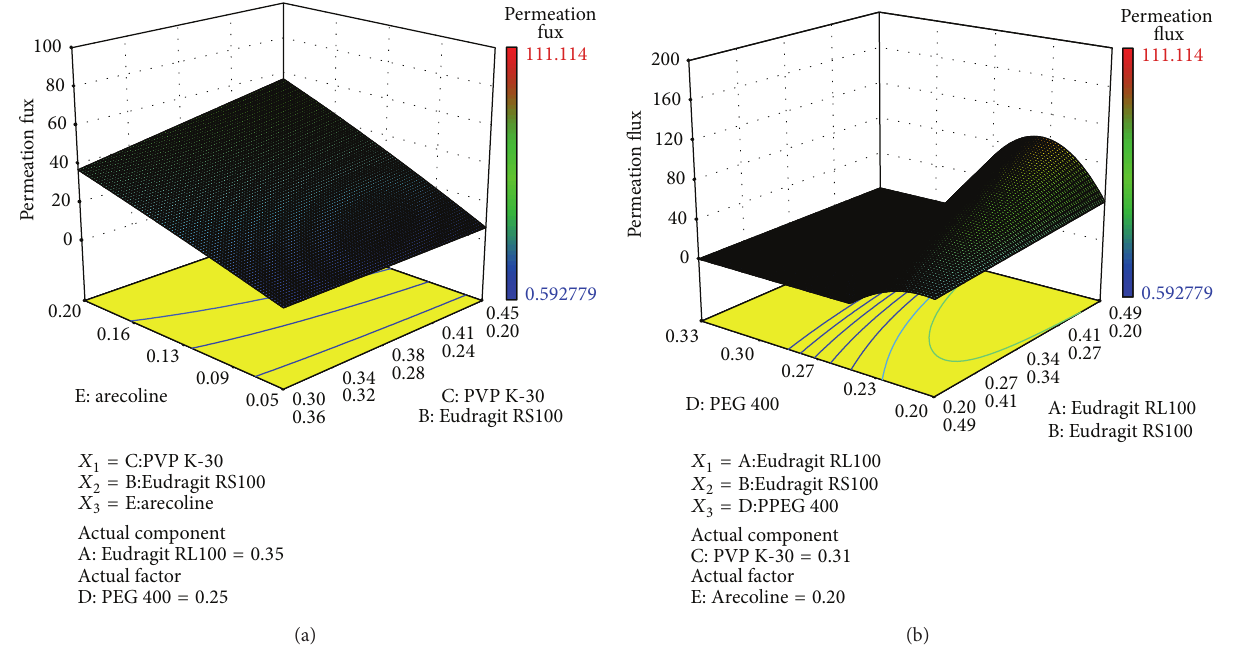
Figure 3: The three-dimensional diagrams illustrating the effect of the level of PEG and arecoline on the permeation capacity of drug from patch.